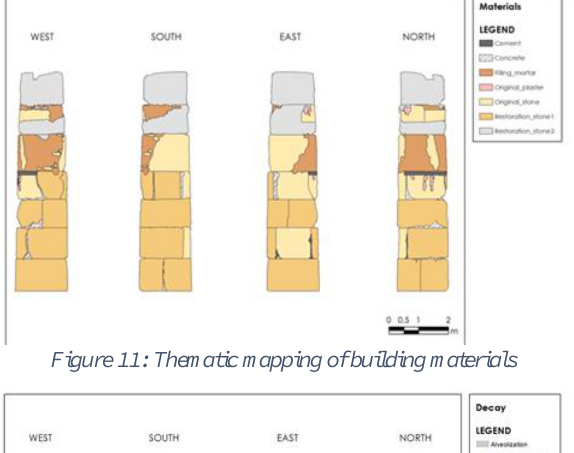
Figure 11: Thematic mapping of building materials